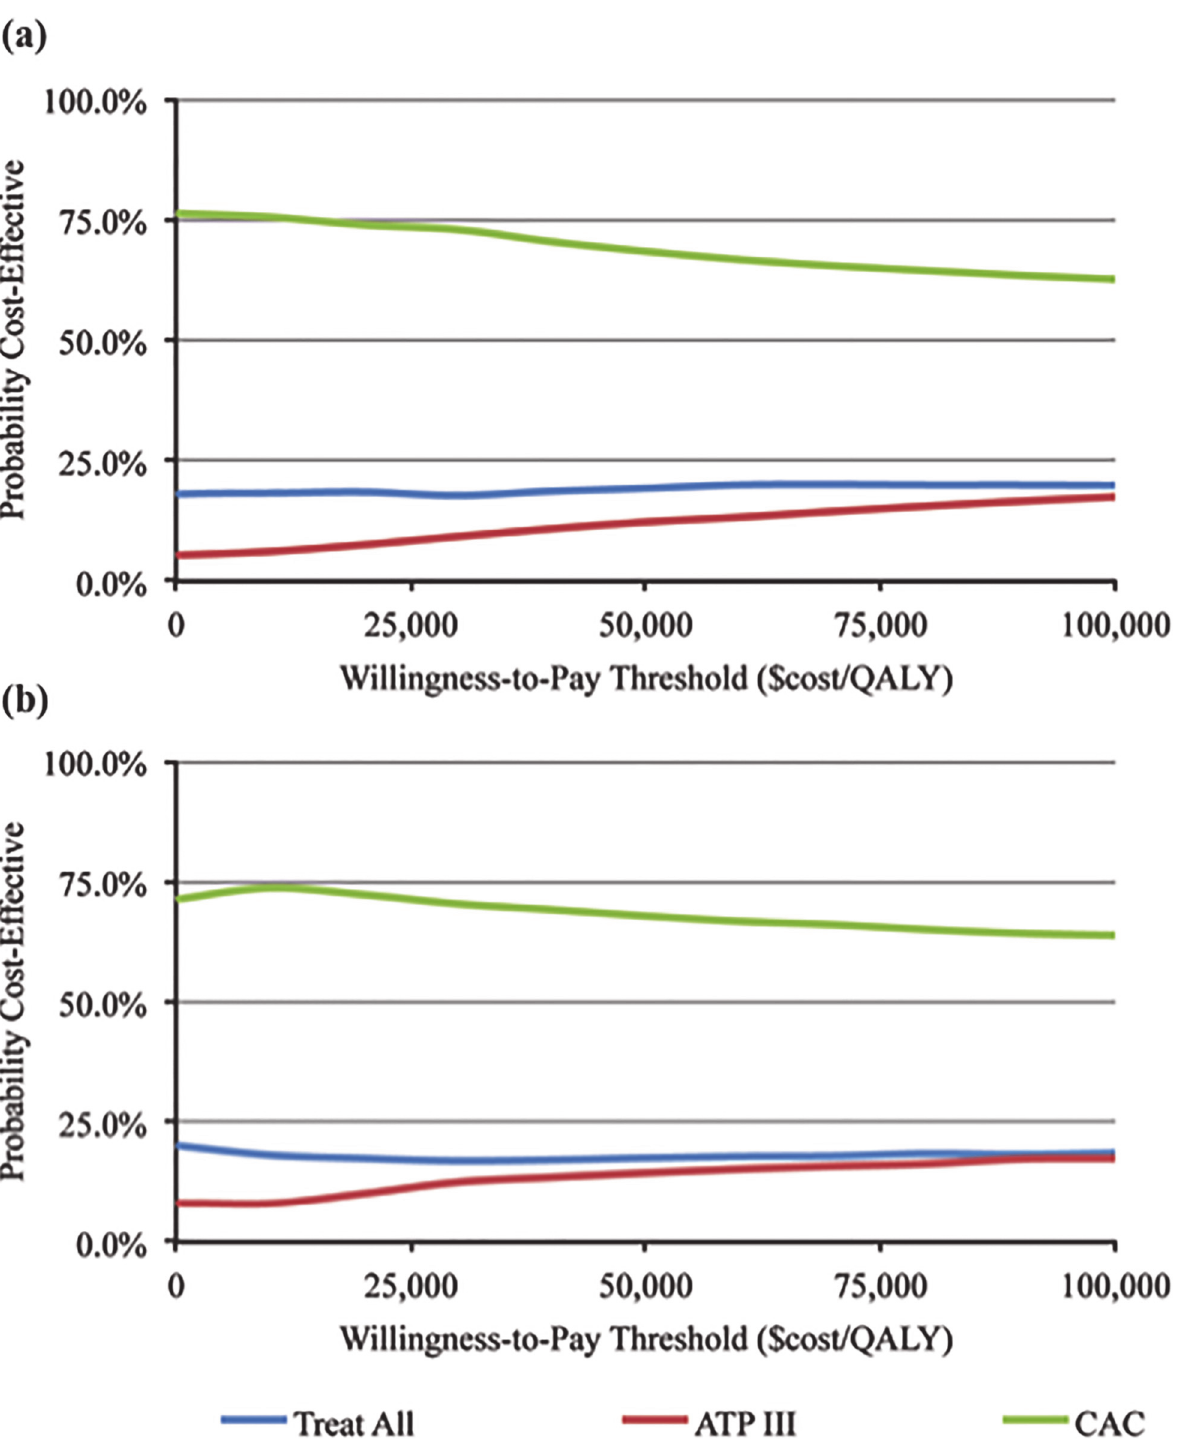
Fig 2. Cost-Effectiveness Acceptability Curves. Panel (a): 10-Year CVD Events, Treat CAC (cid:1) 1. Panel (b): 10-Year CVD Events, Treat CAC (cid:1) 100. Note: The cost-effectiveness acceptability curves show the proportion of simulations (vertical axis) that are cost-effective at a given willingness-to-pay threshold (horizontal axis). A mean CAC scanning cost of $100 and a mean statin cost of $180 is assumed in both plots (indirect costs and costs associated with incidentalomas are not included). The vertical intercept of each cost-effectiveness acceptability curve includes simulations that are cost saving and which result in a loss of fewer QALYs compared to the alternative scenarios. The intercept can be interpreted as the probability that a strategy would be accepted at a willingness-to-pay threshold of $0/QALY. For example, approximately 75% of simulations in both CAC strategies would be accepted at the $0/ QALY